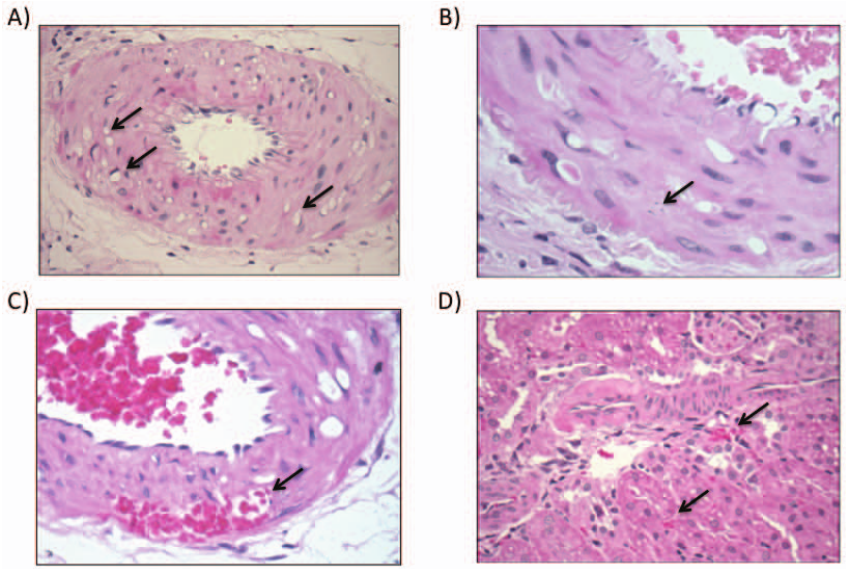
Figure 6. Temporal progression of microvascular injury in kidneys from cyp1a1-Ren2 transgenic rats. (A) After 1 day of transgene activation myocycte vacuolation was observed in the media of the larger arteries (indicated by arrow). (B) After 3 days apoptotic nuclear fragments were observed (arrow) and (C) there were areas of hemorrhage into necrotic foci. (D) After 7 days, vasculopathy was more extensive still and there were foci of tubulointerstitial injury.